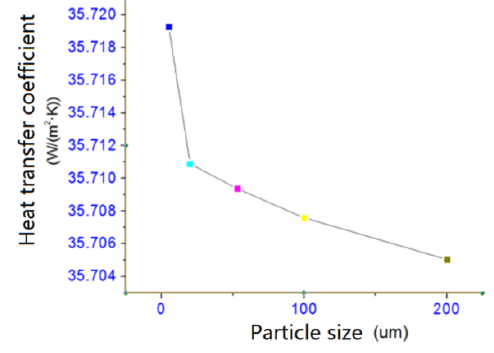
Fig. 4. Effect of particle size on heat transfer